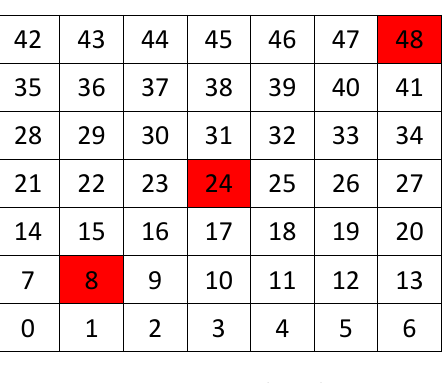
Figure 3. Network